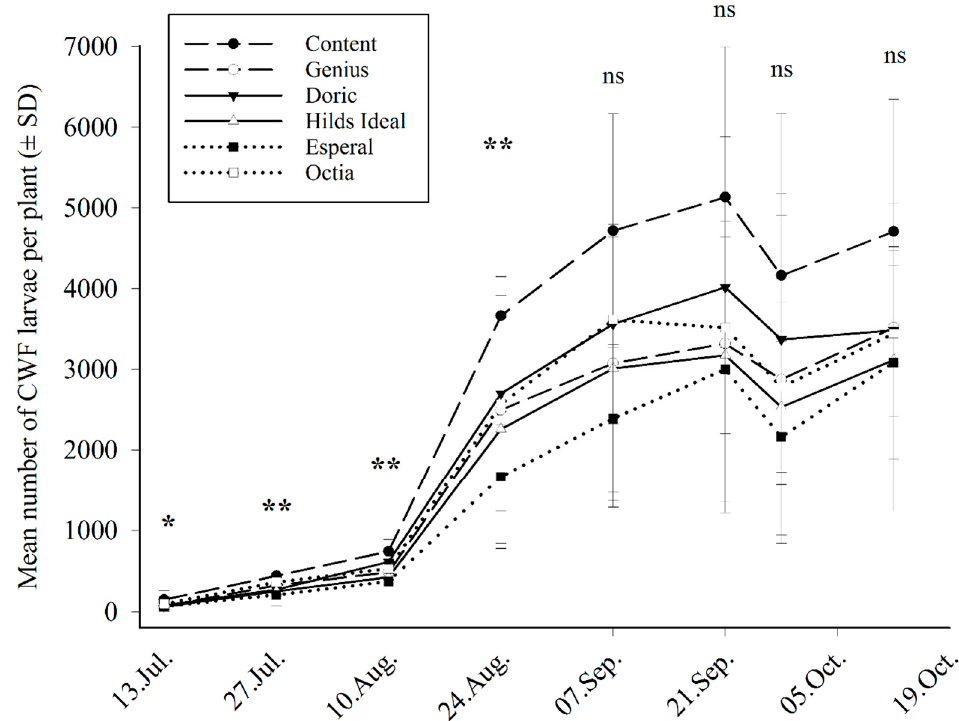
Figure 2. Development of A. proletella (average counts of larvae per plant) on di ff erent Brussel sprout cultivars in a field trial ( ± SD). Dashed lines show attractive, solid lines intermediate and dotted ones unattractive cultivars, according to previous experiments in a greenhouse. Stars indicate significant di ff erences between cultivars at a particular date (LMM, p < 0.05); significance codes: ** = 0.01 * = 0.05.